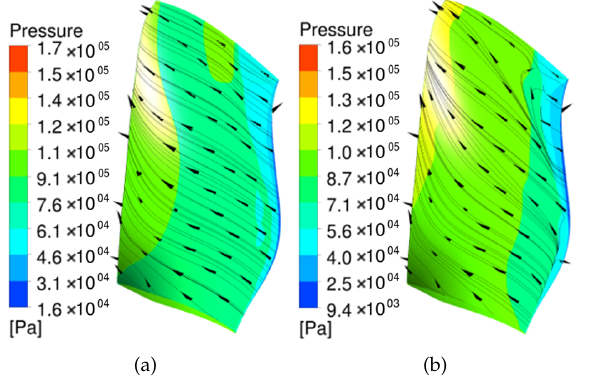
Figure 8. Comparison of surface streamline on the suction surface. ( a ) OP1. ( b ) OP3.